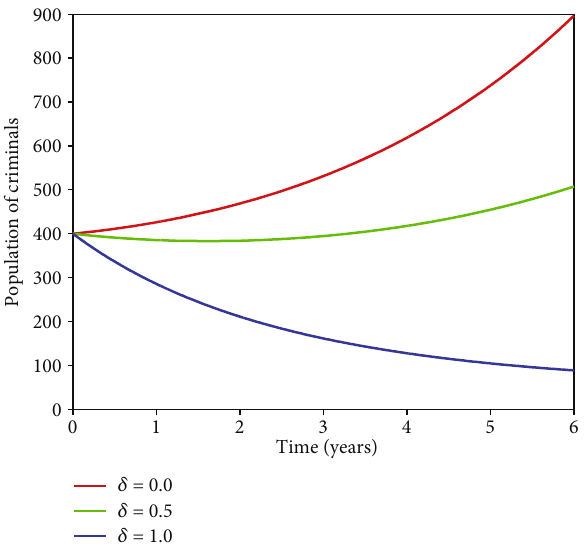
Figure 5: Simulation result showing the impact vocational training on crime population.